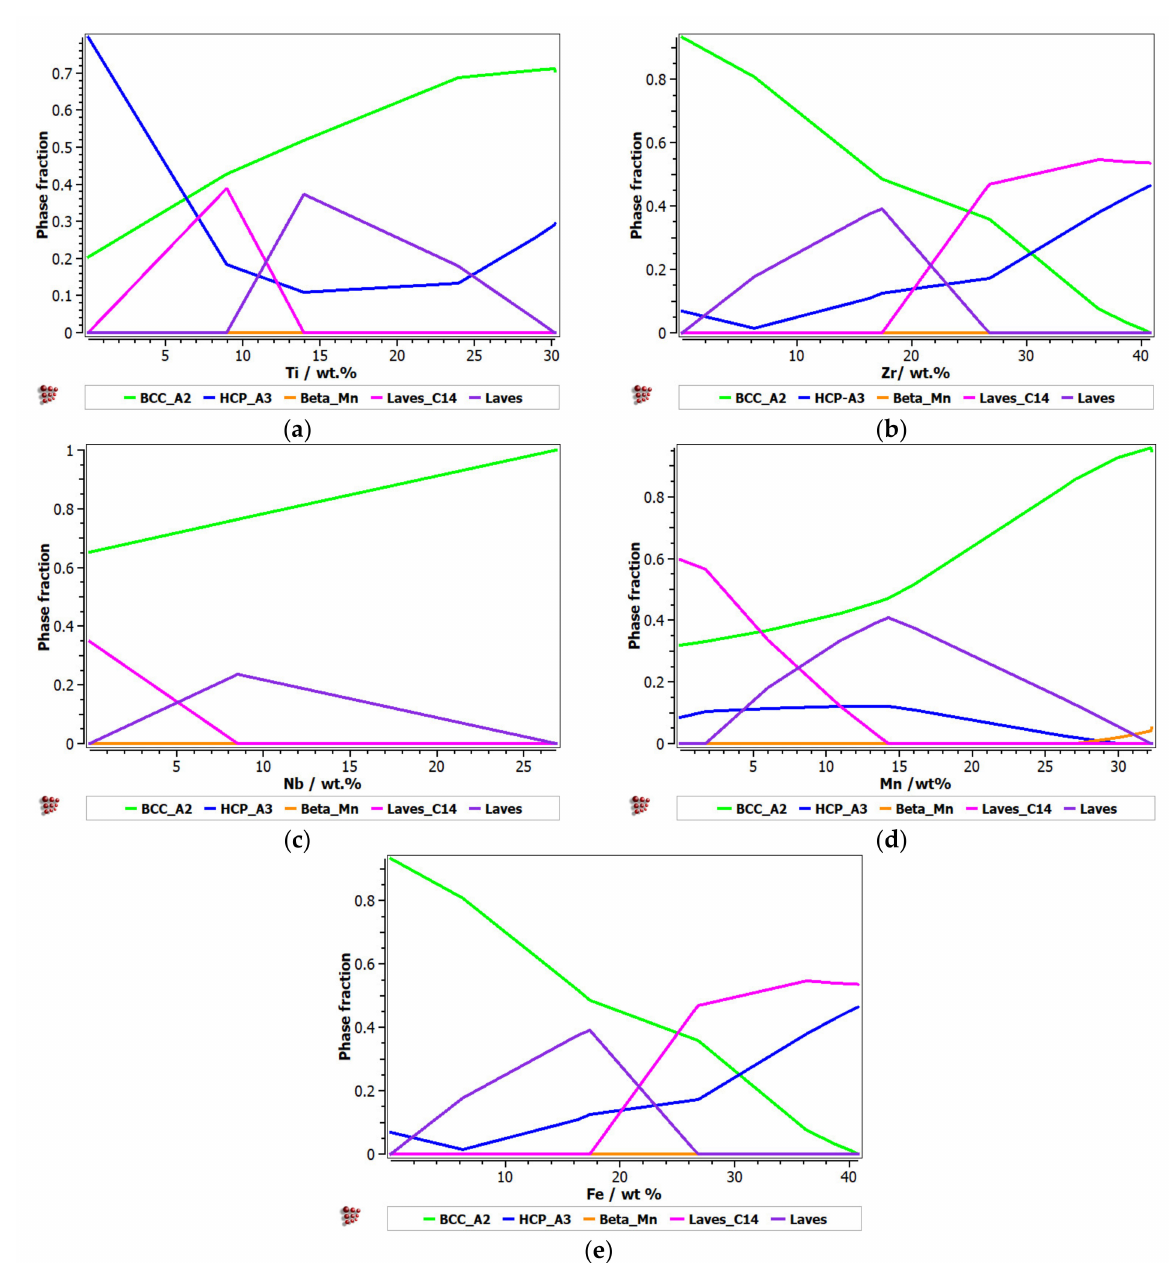
Figure 2. The proportions of phases that can be found in the FeMnNbTiZr alloy system at 200 ◦ C, depending on the variations of ( a ) Ti; ( b ) Zr; ( c ) Nb; ( d ) Mn; ( e )